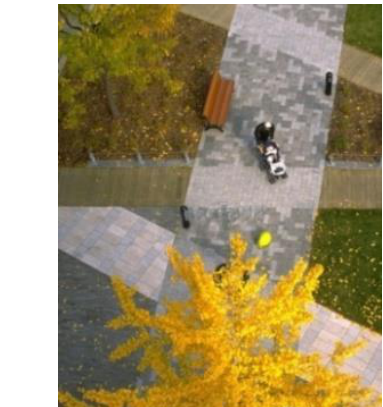
Fig. 11. The designed footpaths in space that reflect direction and clarity in space.